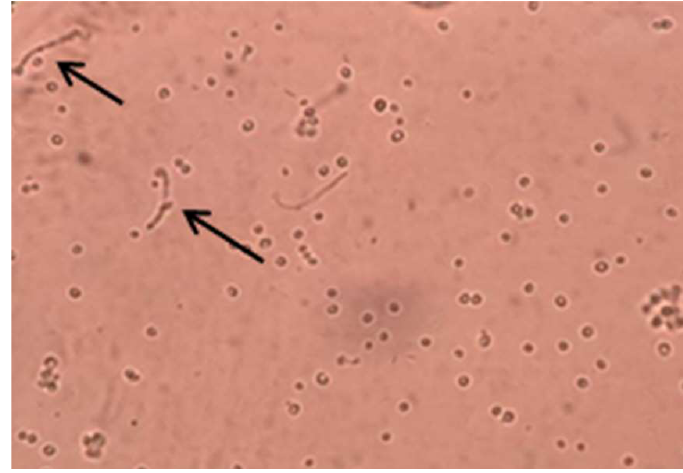
Figure 4. Formation of the C. albicans germ tube.